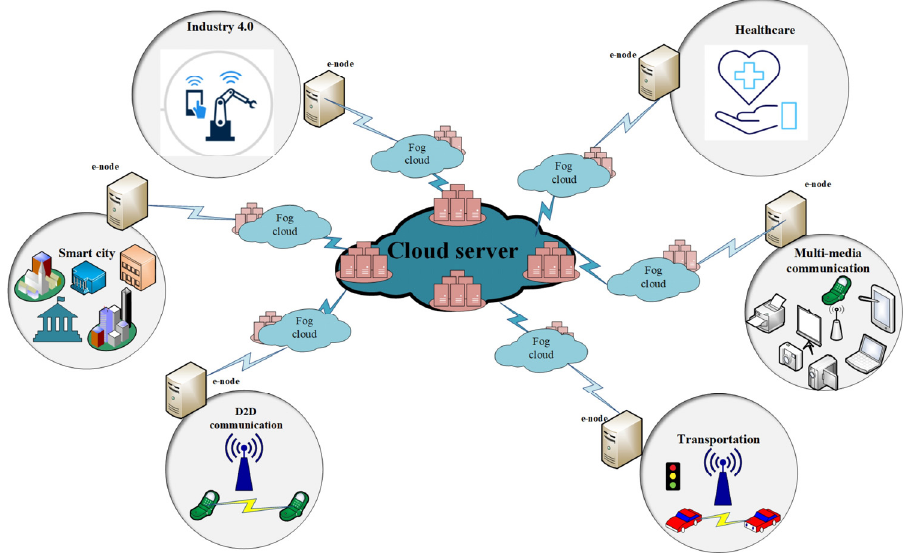
Figure 2. Applications of fog computing.